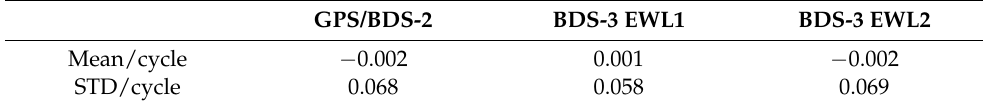
Table 4. Mean and STD values for EWL ambiguity fractions of GPS/BDS-2, BDS-3.